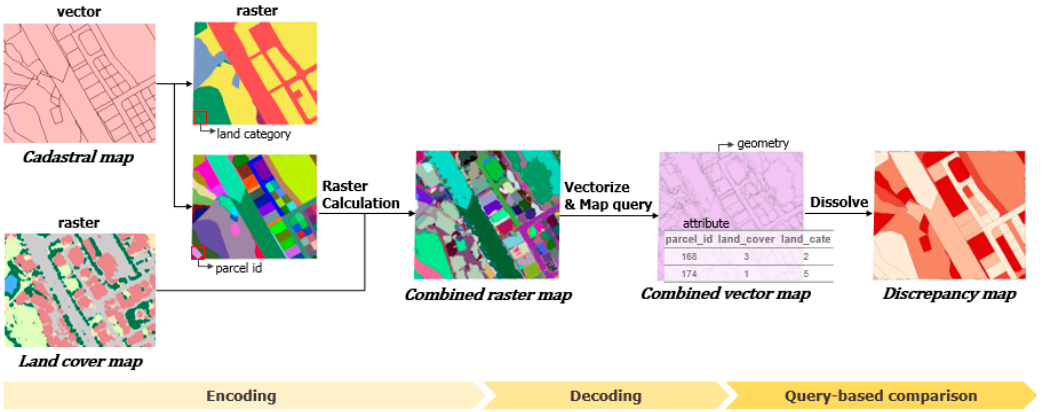
Figure 3. Process of step 2 in discrepancy analysis: inconsistency comparison between cadastral and land cover maps.